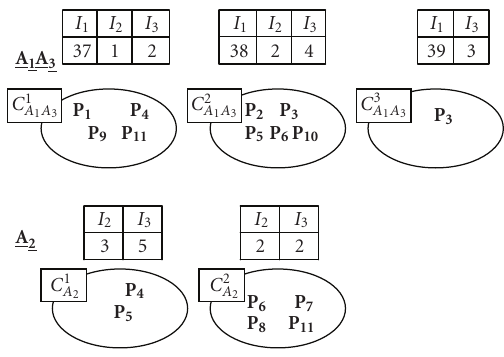
Figure 4: Result of the